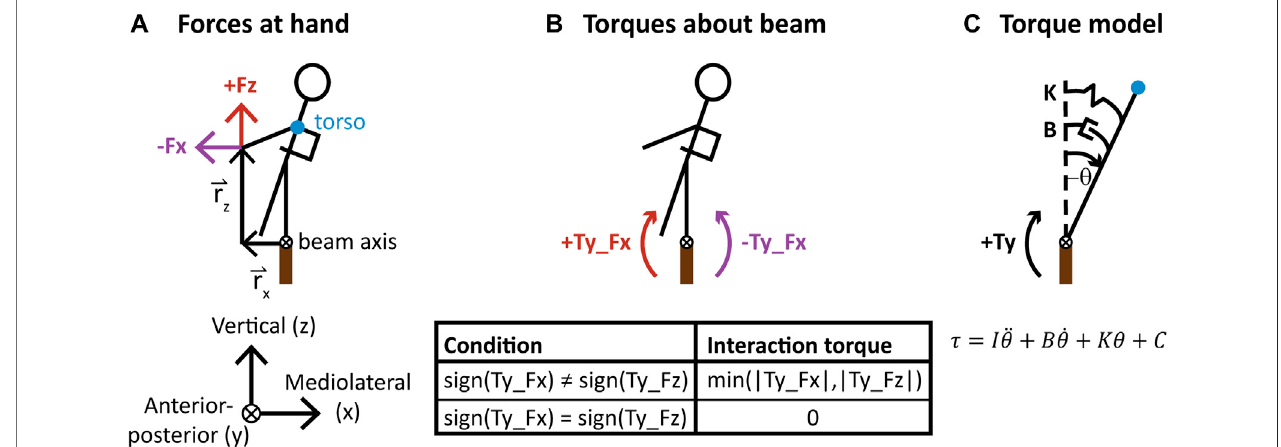
FIGURE 2 | Torque on the beam-walker ’ s body about the beam axis (the midline of the beam points into the page) due to hand interaction forces. (A) Torque components were calculated by multiplying each force component by its moment arm (r), de fi ned as the distance from the beam axis to the beam-walker ’ s left fi nger marker in the frontal plane. Blue dot indicates torso marker. (B) The lateral (x) and vertical (z) hand force components create opposing torques in the frontal planes, and the interaction torque is de fi ned in the table. (C) A mass-spring-damper model is fi t between the beam-walker ’ s angular torso state and each torque component (Ty_Fx and Ty_Fz) separately. Blue dot indicates torso